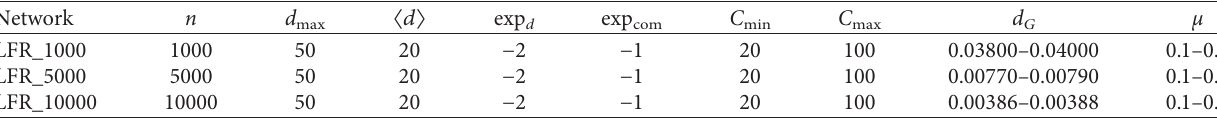
Table 1: The options of LFR network generator used for producing the 2 series of artificial networks. n is the number of vertices; d max and 〈 d 〉 are the maximum and the average degree of vertices; exp d and exp com are the exponents of the power-law distributions followed by the degree and the community size; C min and C max are the minimum and maximum number of vertices in a community; d G is the density of the network; μ is the mixed parameter, which controls the ratio of edges for each vertex connecting outside of the community to the total edges associated with that